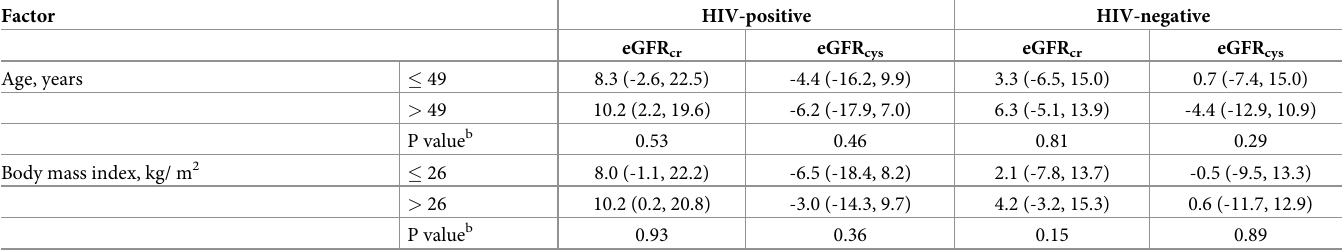
Table 4. Factors associated with glomerular filtration rate equation bias a in HIV-positive and HIV-negative participants.